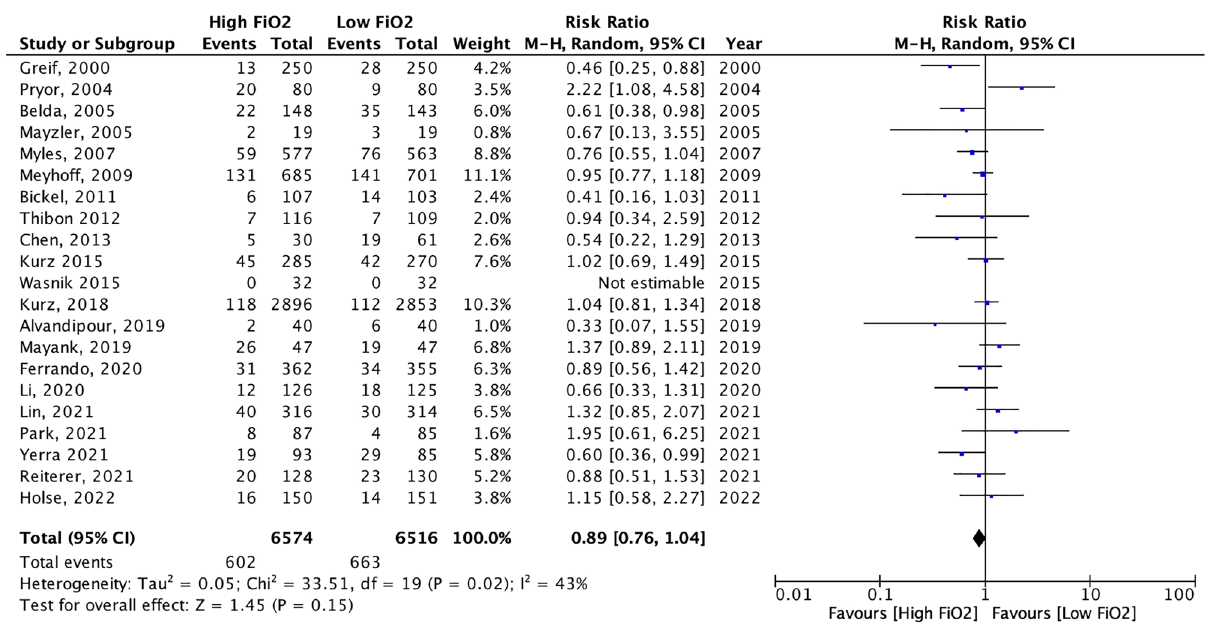
Figure 5. Sensitivity analysis of high vs. low intraoperative FiO 2 on the incidence of SSI in patients operated from abdominal surgery, included in the 18 studies having exclusively included patients operated from abdominal surgeries and in the 3 studies having included mixed surgeries.